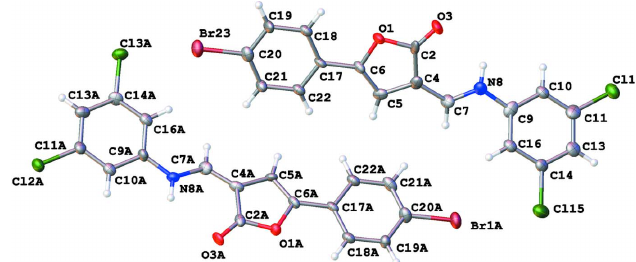
Figure 1 The asymmetric unit of the title compound with the atom labelling and displacement ellipsoids drawn at the 50% probability level (two crystallographically independent molecules are shown).